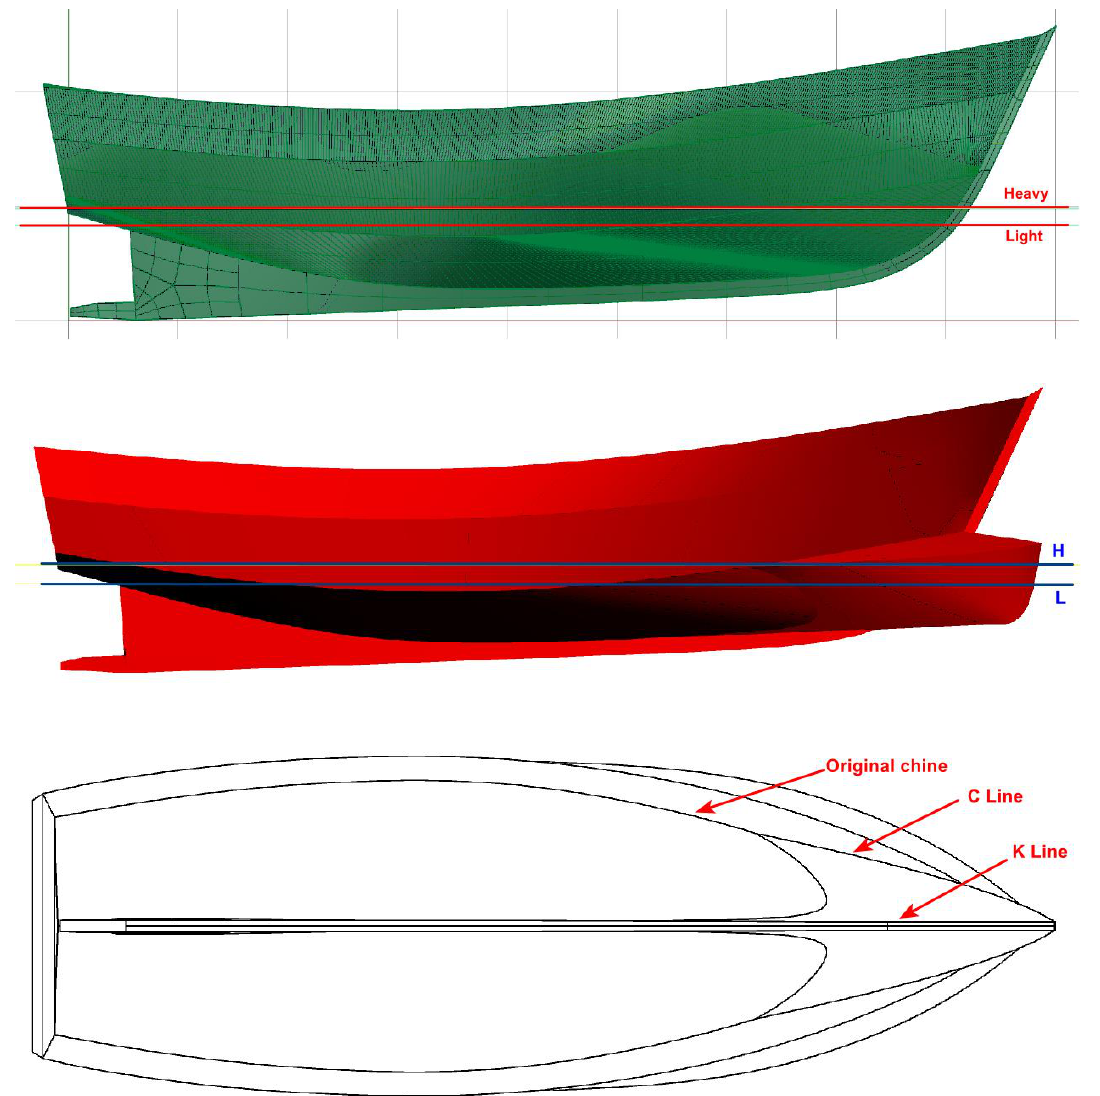
Figure 11. Comparison between FAO1 and FAO2 geometry.